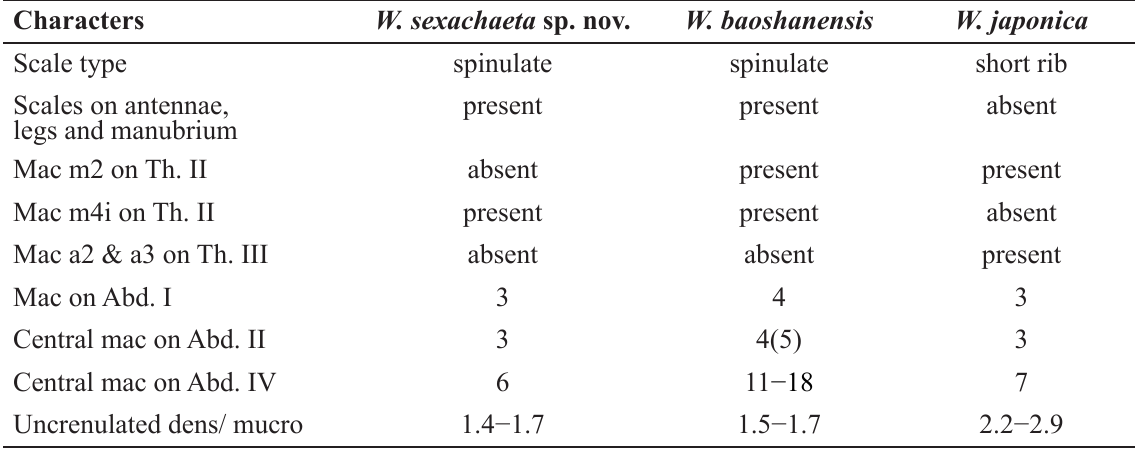
Table 2. Comparison of W. sexachaeta sp. nov., W. baoshanensis Chai & Ma, 2017 and W. japonica Folsom 1898.